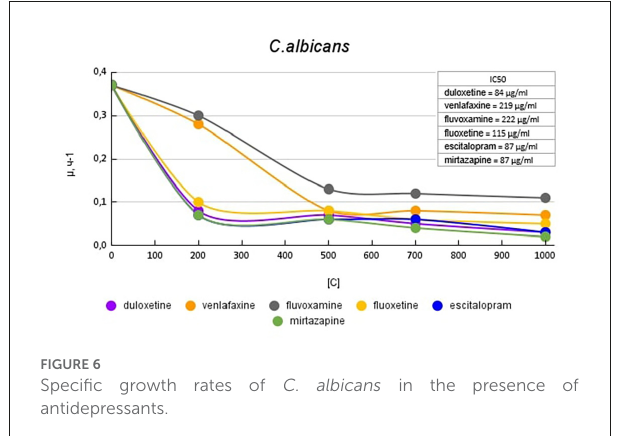
µ g/ml, it reduced the growth rate by 1.2 (17%) times compared with the